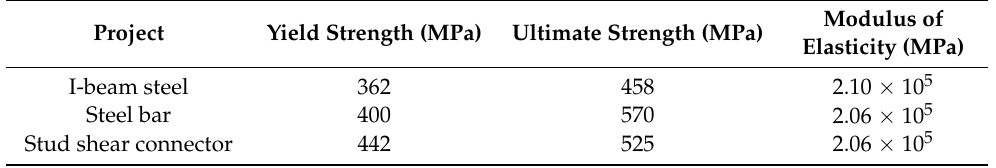
Table 2. Material test results.